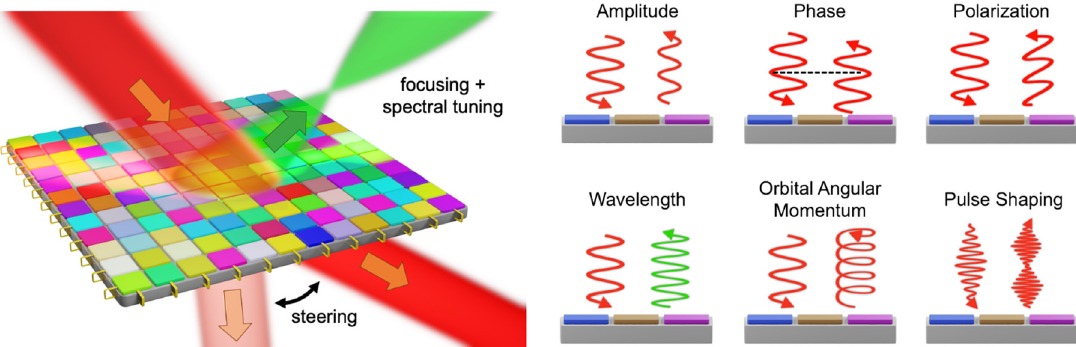
Figure 2: Schematic of a universal active metasurface enabling dynamic wavefront shaping in reflection and transmission. This metasurface should allow for dynamic and independent control of the amplitude, phase, polarization, wavelength, the orbital angular momentum, and pulse shape of an electromagnetic